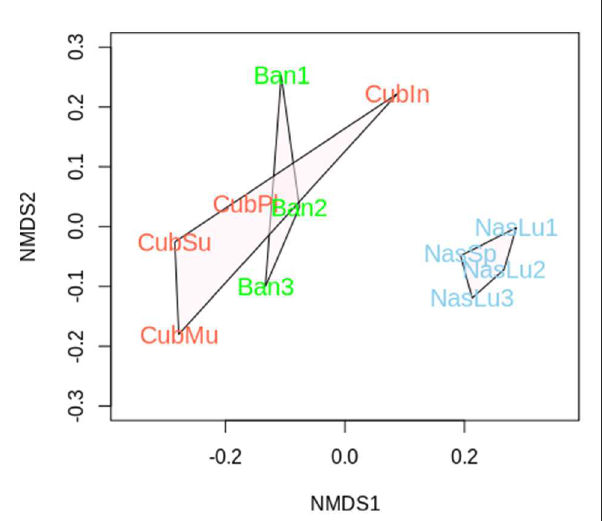
FIGURE6 Non-metric multidimensional analysis considering all the samples sequenced in this study (metagenomic shotgun